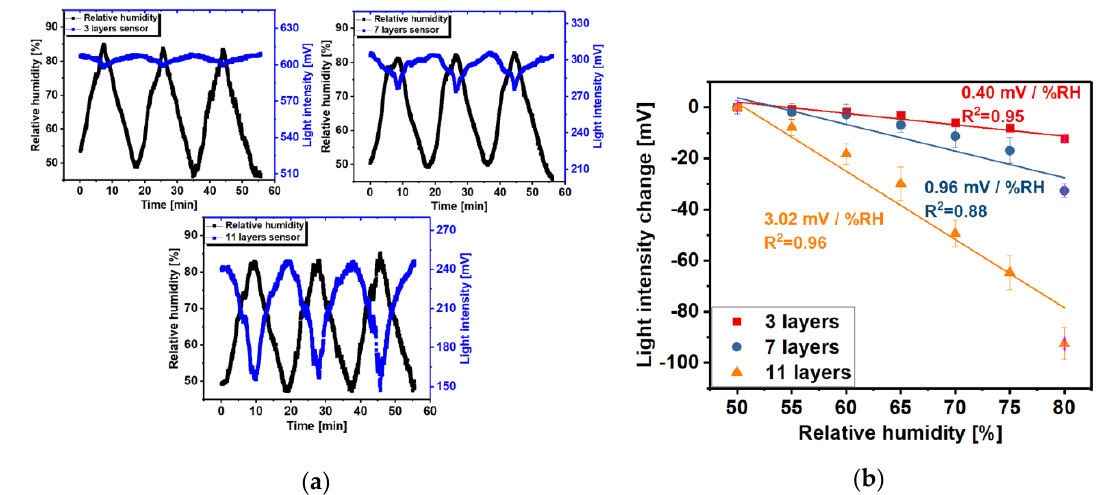
Figure 4. ( a ) Dynamic light intensity changes of OFHS with di ff erent layers (top left: 3 layers, top right: 7 layers, bottom: 11 layers) thin film (blue curve, PAH / SiO 2 NPs) on exposure to a humidity changing environment. The black curve is the RH change measured by the commercial sensor. The temperature is fixed at 30 ◦ C in the climatic chamber for the duration of the experiment. ( b ) Calibration curves for OFHSs with 3, 7 and 11 layers thin film represent the sensitivity for each case (error bars represent the standard deviation of three repeat cycles). For the purpose of comparison, the Y-axis in the calibration curve shows the di ff erences in reflected light intensity relative to the left experimental